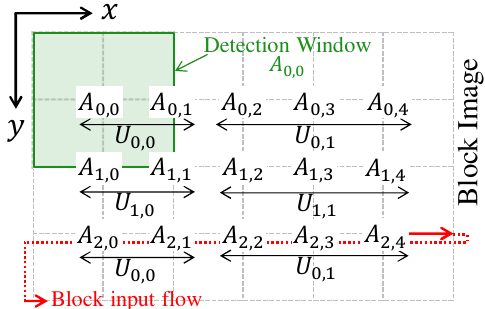
Figure 9. SVM Units Distribution Example. In this example, N c = 2, N r = 2, and the detection window dimension is 2 × 2 blocks. The terms U r , c and A y , x mean respectively SVM unit and detection